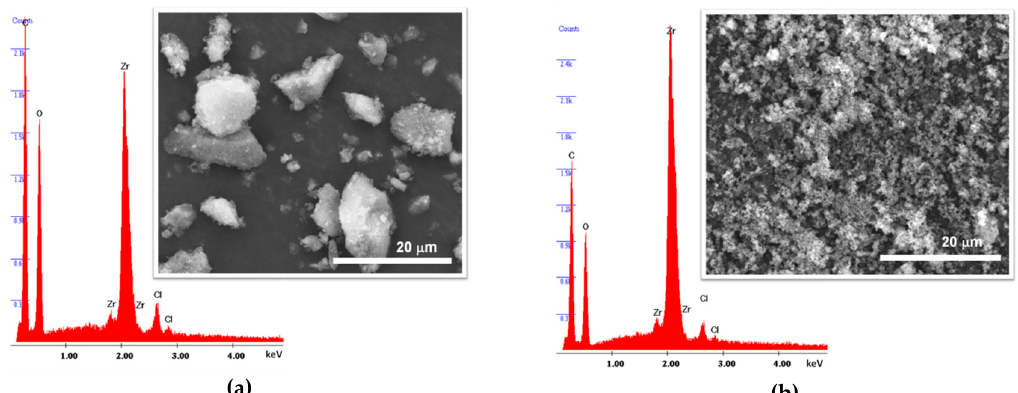
Figure 3. Electron dispersive X-ray spectroscopy (EDS) spectra and SEM images for the ( a ) UiO-66(Zr)-S1 and ( b ) UiO-66(Zr)-MW2 materials.